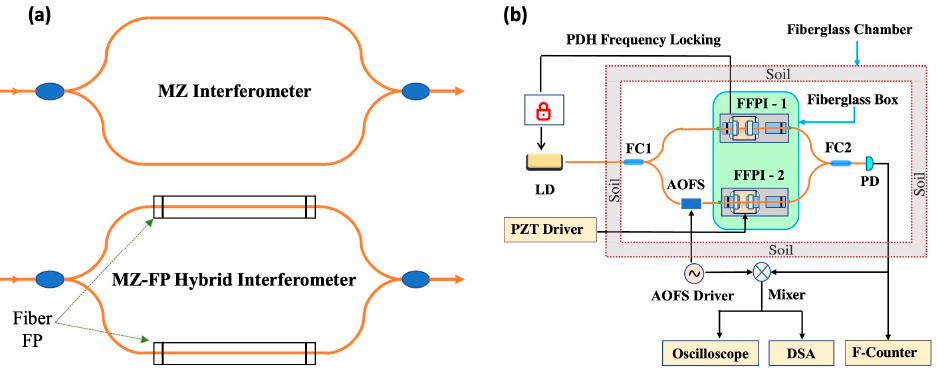
Figure 1. ( a ) The concept of the MZ-FP hybrid interferometer in comparison with the conventional MZ interferometer. ( b ) Schematics of the experimental setup. FC: fiber coupler, LD: laser diode.